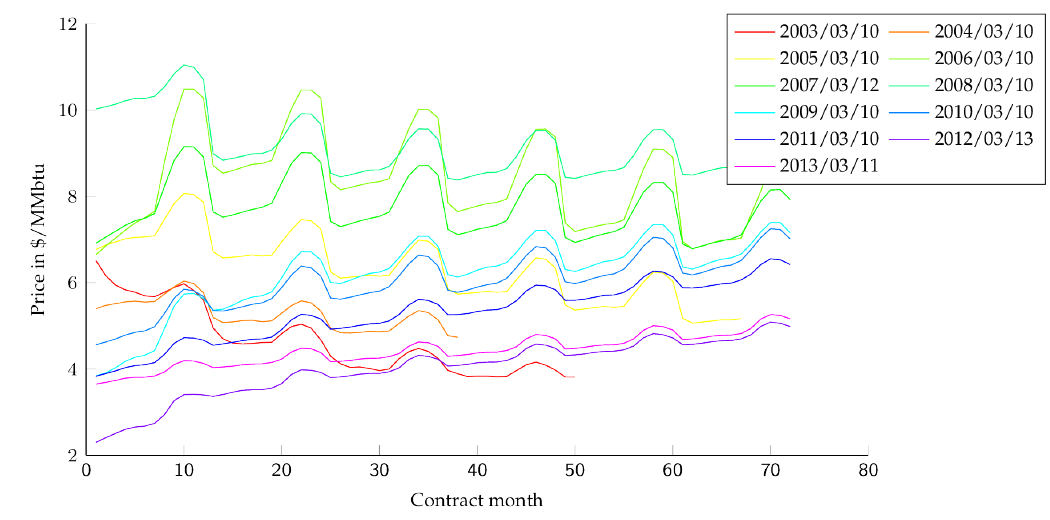
Figure 1. Futures curve for NYMEX NG at different observation